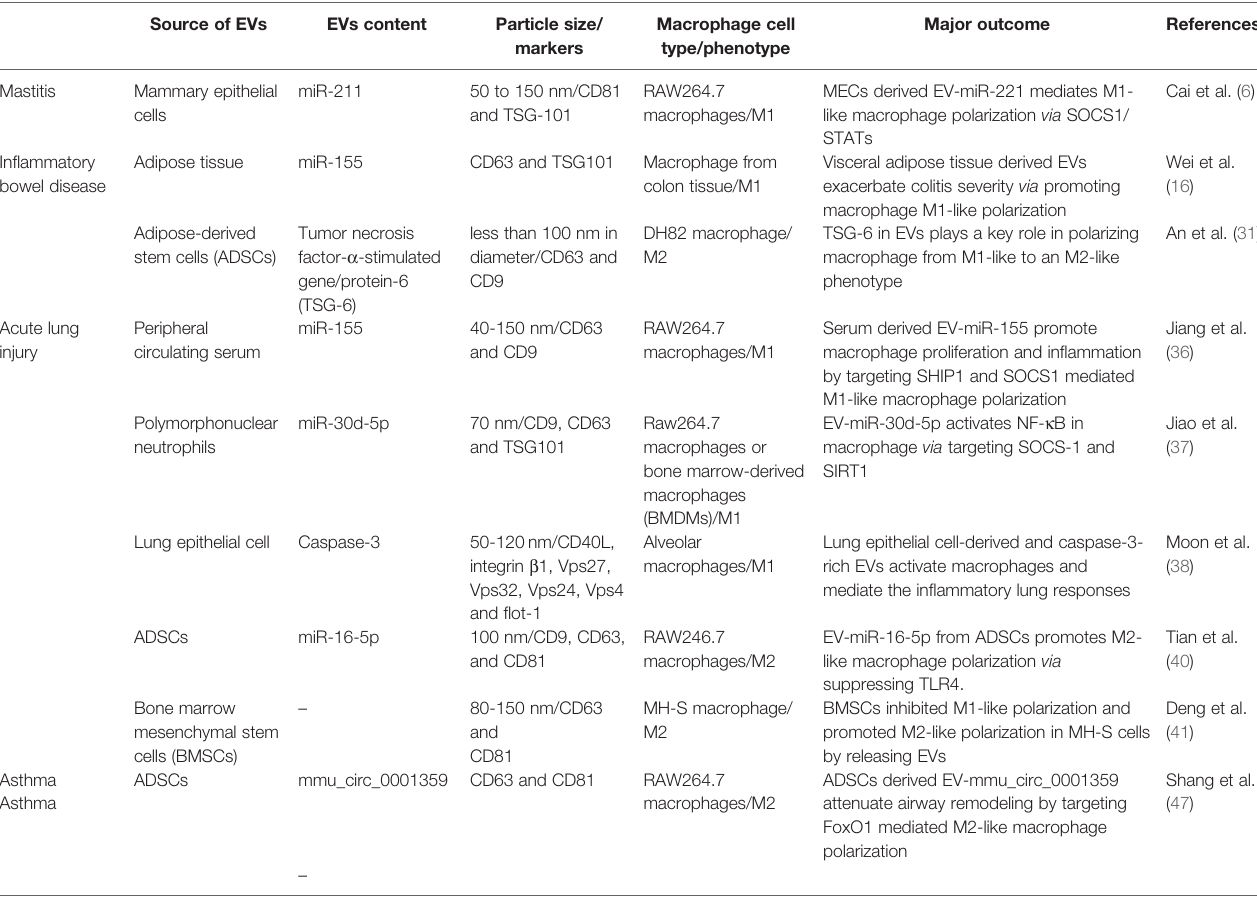
TABLE 1 | The role of EVs in macrophage polarization and pathological signi fi cance in in fl ammatory diseases. Source of EVs EVs content Particle size/